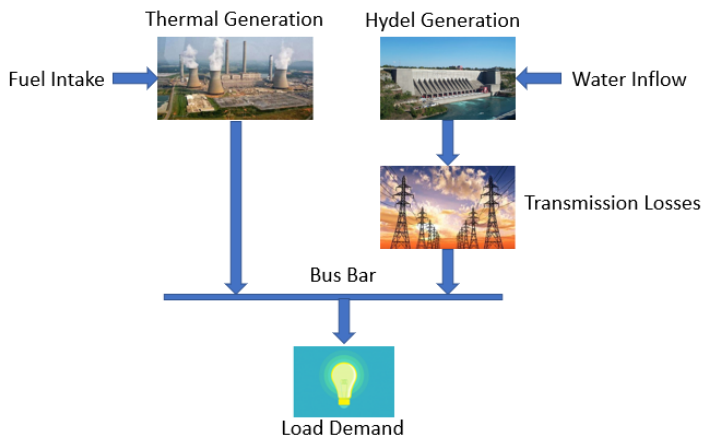
Figure 2. Generation model of the Short-Term Hydrothermal Scheduling (STHTS) problem